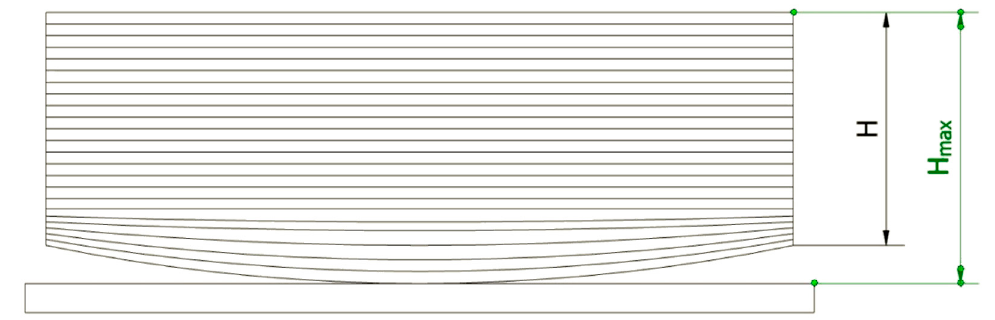
Figure 10. Schematic drawing of vertical edge lift measurements.